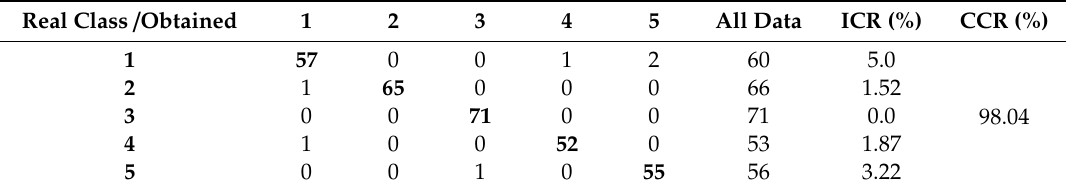
Table 4. Classification results of the test set using the feature-based approach and the hybrid ANN-PSO classifier. ICR: incorrect classification rate by class; CCR: global correct classification rate.